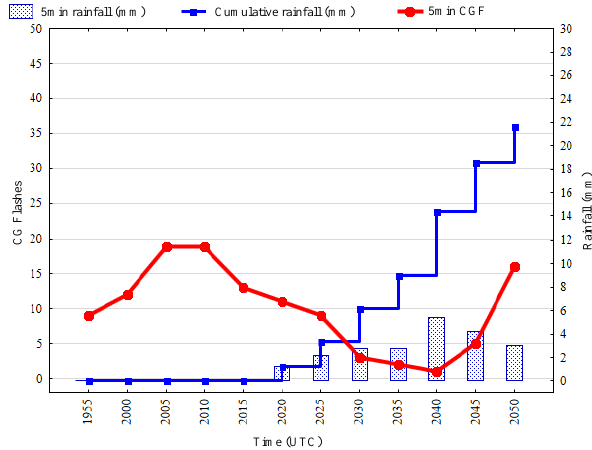
Figure 18. Critical interval time series for debris flow event of 4 July 2011. This is an event from the HL group and debris flow initiation was observed at